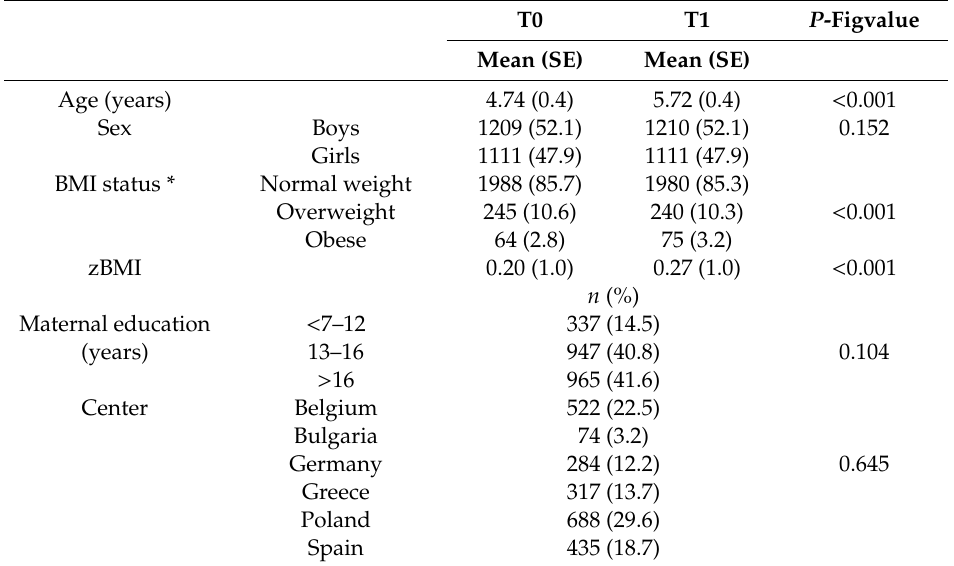
Table 1. Descriptive characteristics of European preschool children participating in the ToyBox-study.